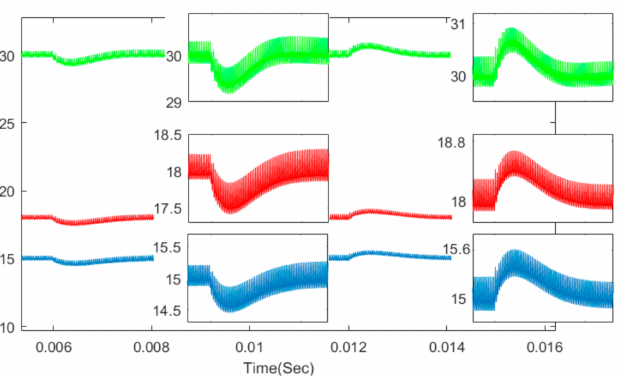
Figure 20. Channels’ output voltage of the proposed power supply in response to a ± 10% load